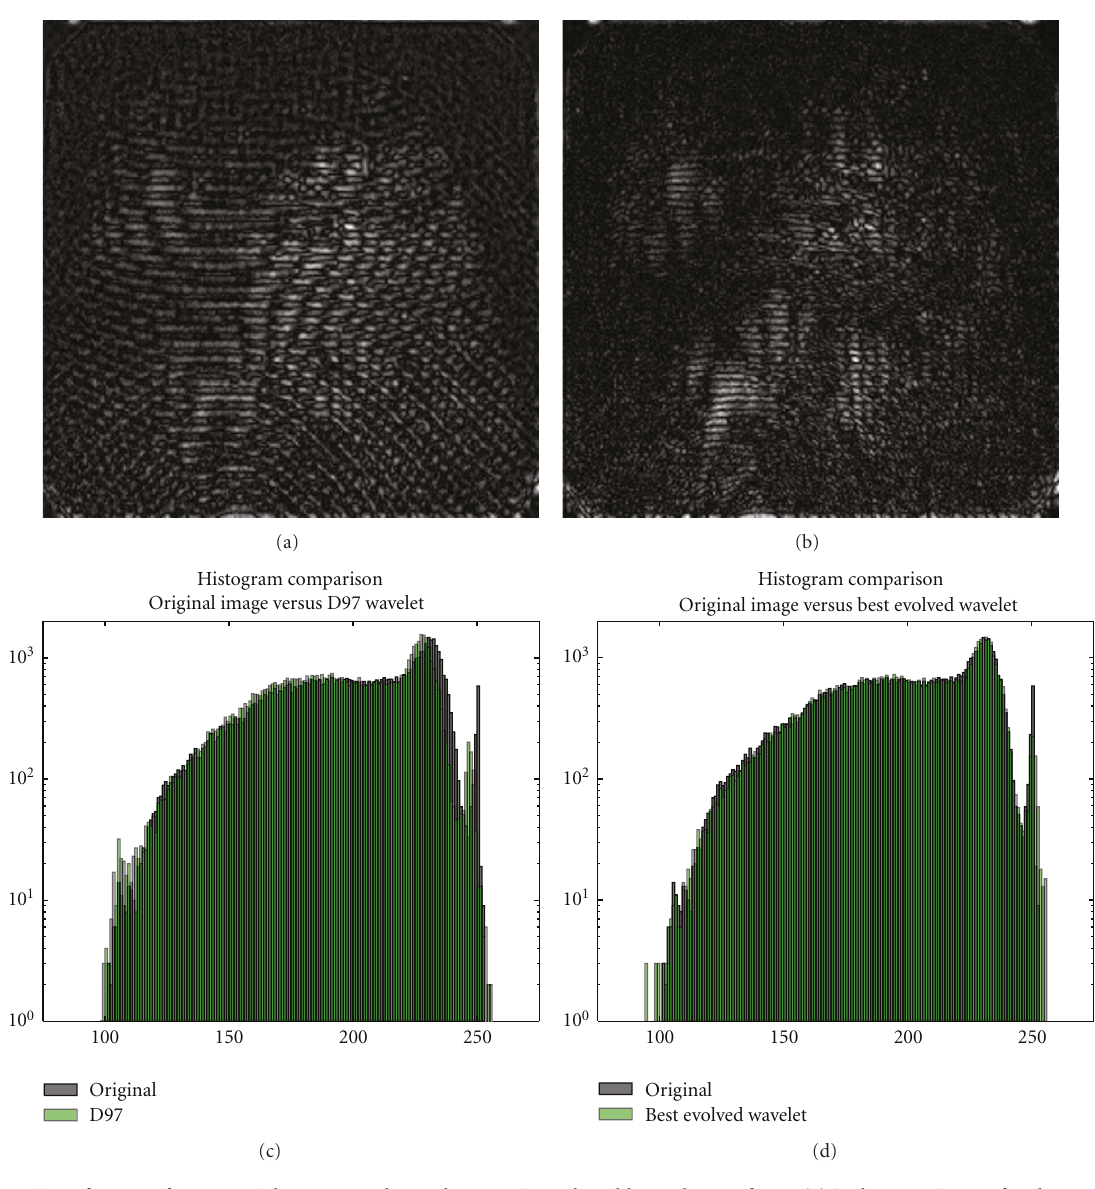
Figure 17: Transform performance. The top row shows the error introduced by each transform: (a) is the error image for the D97 wavelet and (b) for the best evolved individual. The bottom row shows the histograms of each image transform, where: (c) is for D97 and (d) for the best evolved